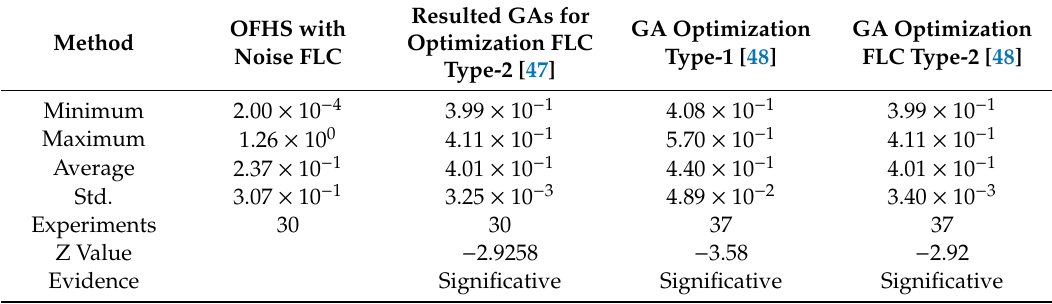
Table 19. Statistical test results for